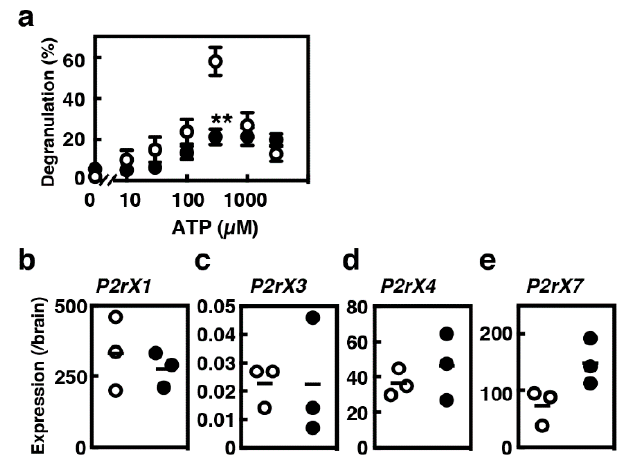
Figure 4. Comparison of the profiles of ATP-induced degranulation between BMMCs and MCs/IL-9. ( a ) BMMCs (open circles) and MCs/IL-9 (closed circles) were stimulated with the indicated concentrations of ATP. The levels of degranulation were determined by measuring the enzymatic activity of β -hexosaminidase. Values are presented as the means ± SEM ( n = 4). Multiple comparisons were performed using two-way ANOVA with the Sidak test. A value with ** p < 0.01 is regarded as significant. ( b – e ) The levels of mRNA expression of ( b ) P2rx1 , ( c ) P2rx3 , ( d ) P2rx4 and ( e ) P2rx7 in BMMCs (open circles) and MCs/IL-9 (closed circles) were measured by quantitative RT-PCR.